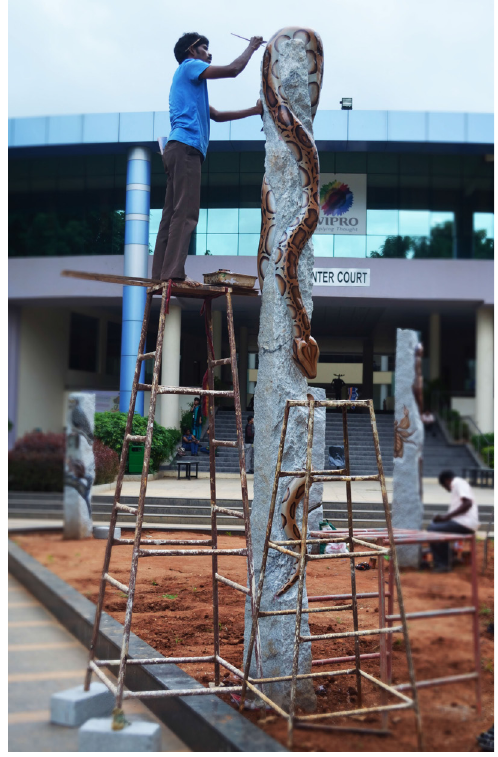
WIPRO Technologies, Electronic City,